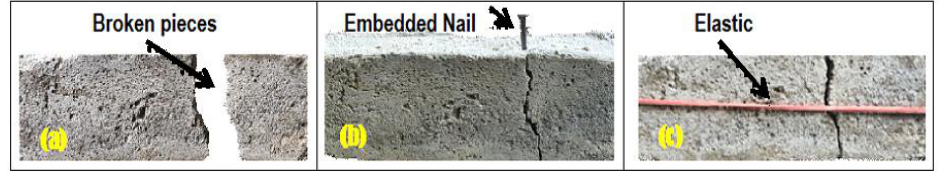
Figure 1. Artificial crack creation in mortar samples; ( a ) broken pieces; ( b ) Nail embedded in crack-creation setup; ( c ) post-crack before healing which was held using